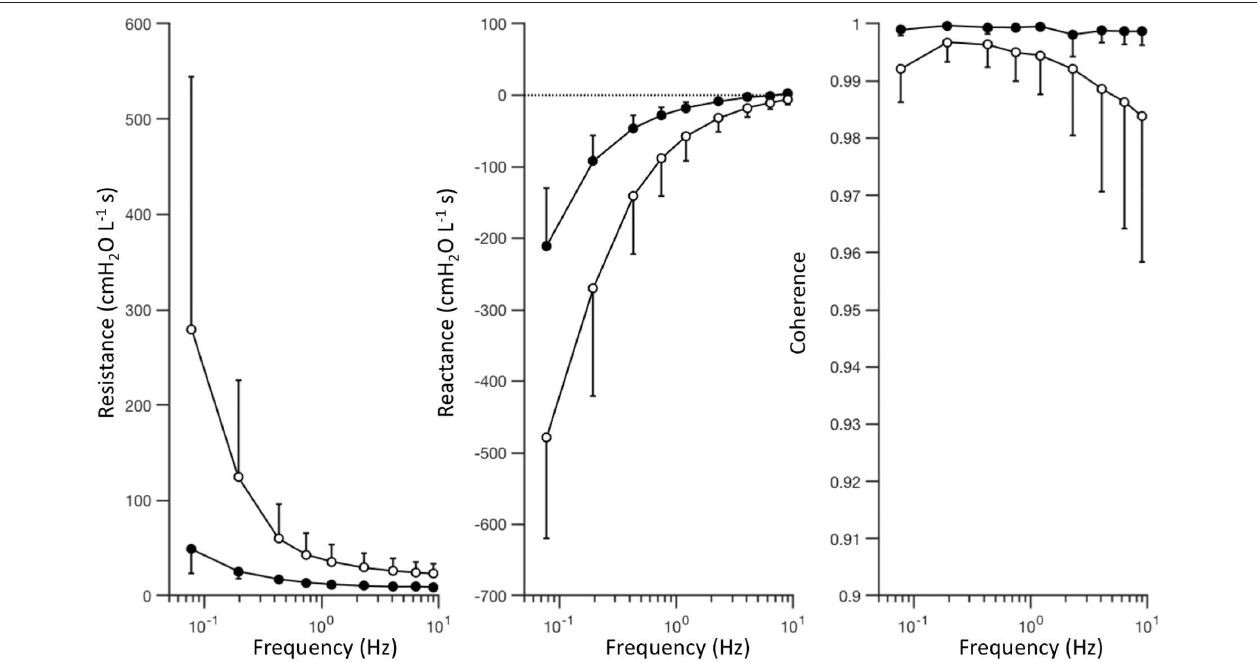
FIGURE 4 | Respiratory impedance measured under baseline (black) and injured (white) conditions, represented by the mean value (circles) and standard deviation (error bars) at each frequency, across subjects. The complex-valued impedance spectrum is represented by its real part or in-phase component (i.e., resistance), and its imaginary part or out-of-phase component (i.e., reactance). Coherence provides an estimate of signal quality and linearity of the measured relationship between pressure and flow oscillations.